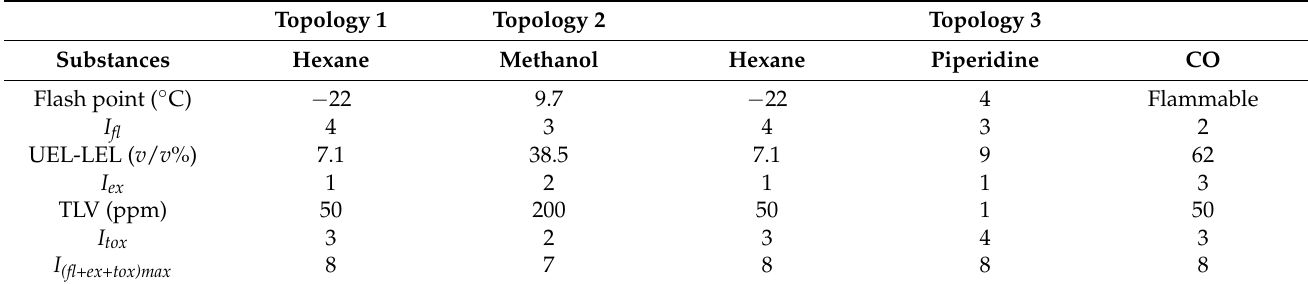
Table 3. Safety parameters for dangerous substances.